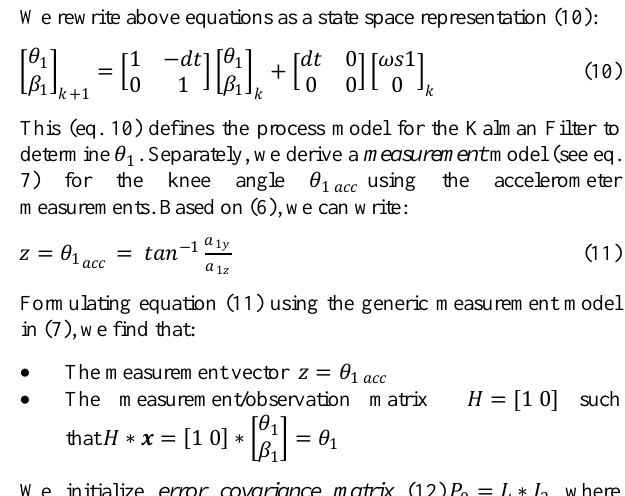
Figure 3 Kalman Filter